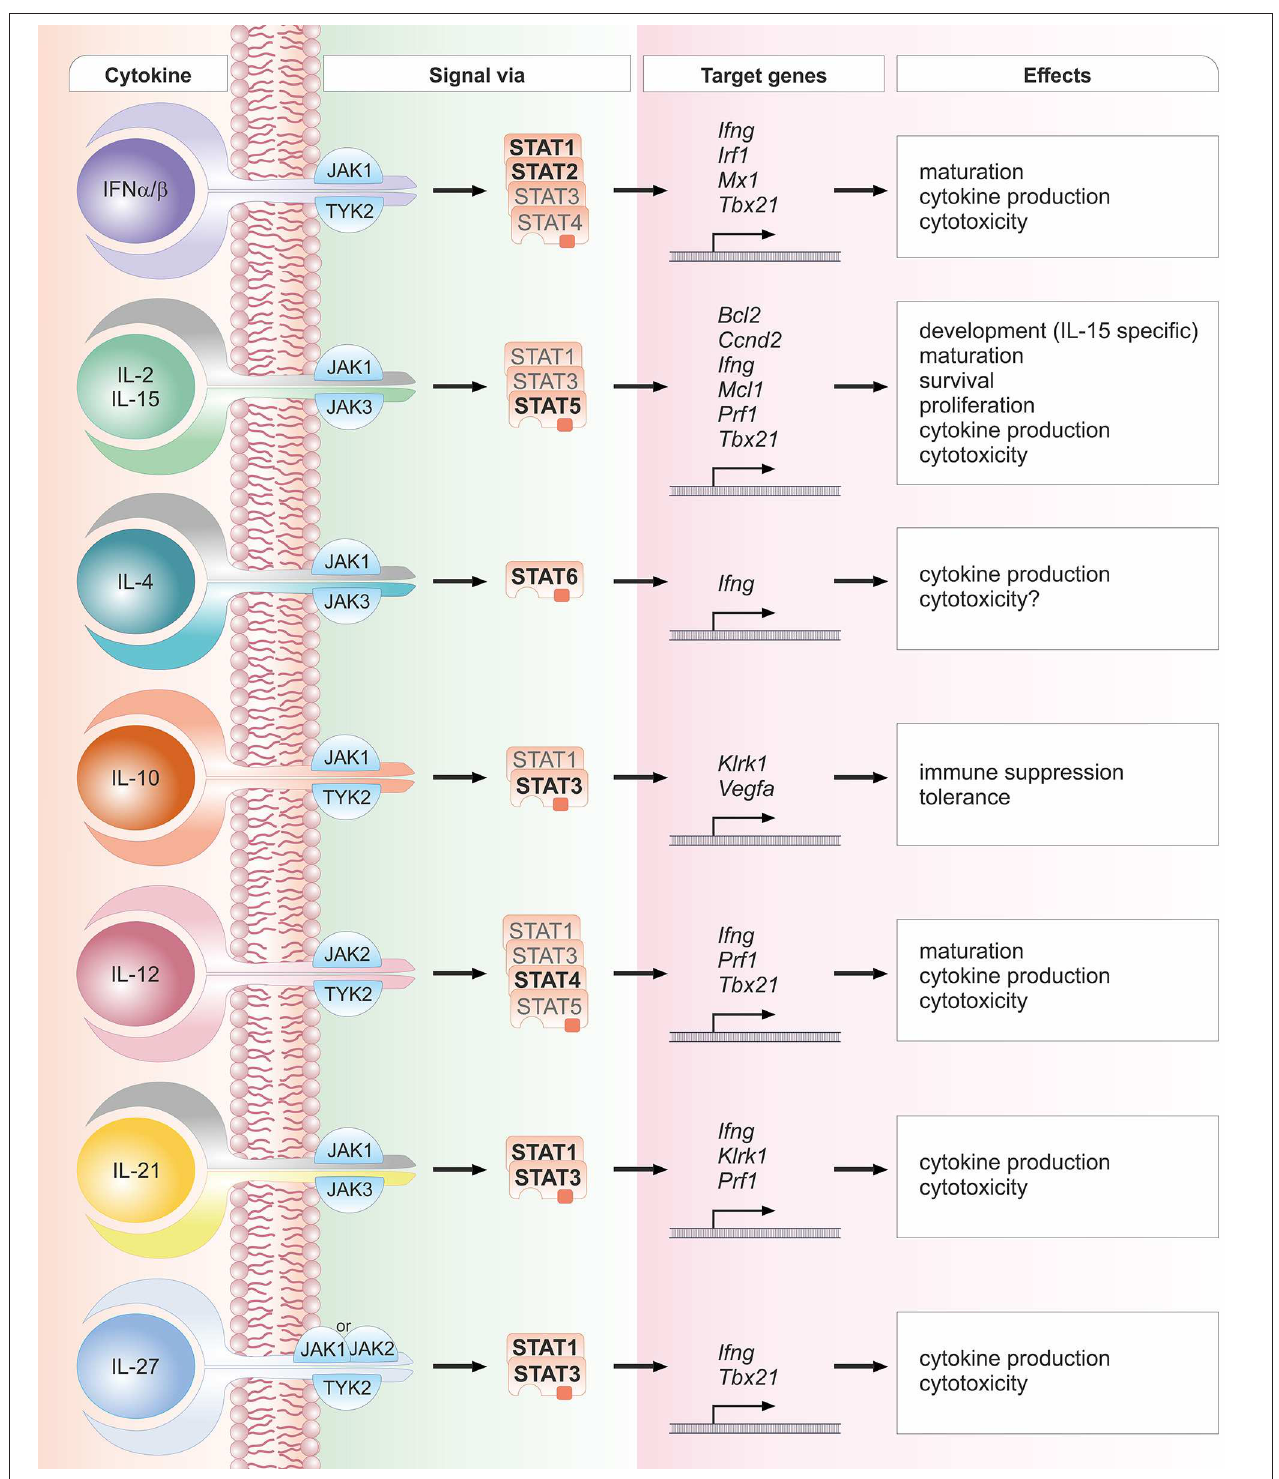
FIGURE 2 | Schematic overview of crucial cytokines in NK cell biology, their associated JAK and STAT proteins, exemplary target genes and biological effects. One cytokine can lead to the activation of several STAT proteins. STAT proteins predominantly activated by the respective cytokine are depicted in bold font; STAT proteins that have been reported to be activated to a lesser extent are depicted in light font. The details and references for distinct cytokine signaling cascades and the functional responses can be found in the corresponding sections of the main text.